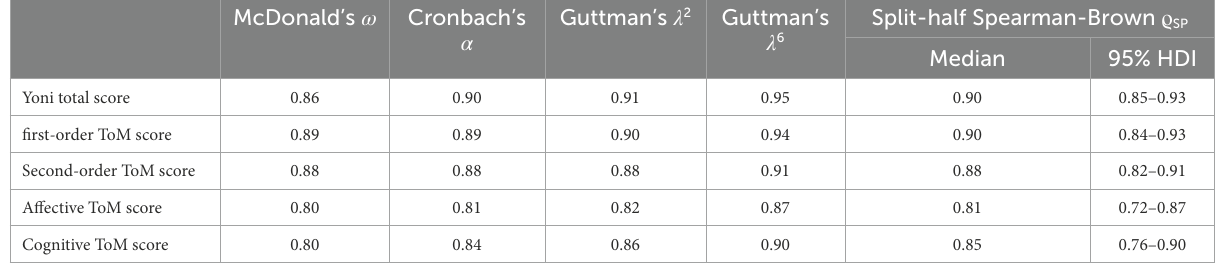
TABLE 4 Yoni-48’s inter-item and split-half reliability.